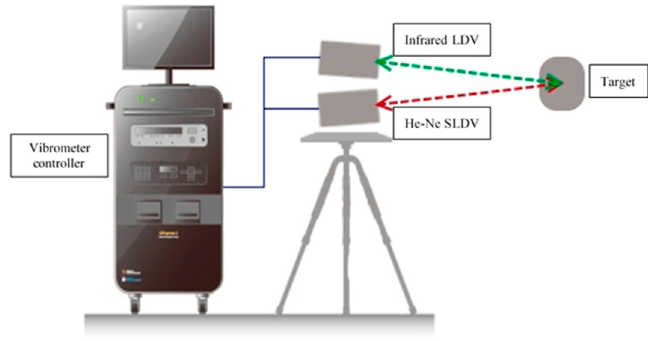
Figure 1. First experiment: noise floor measurement with two measuring systems on different targets.